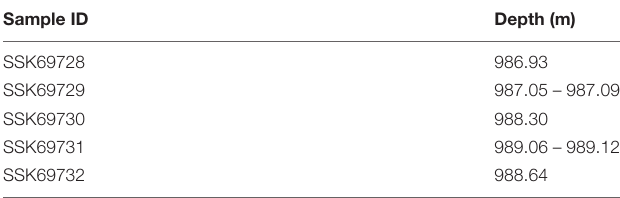
TABLE 2 | Depths for samples taken for Petrographic